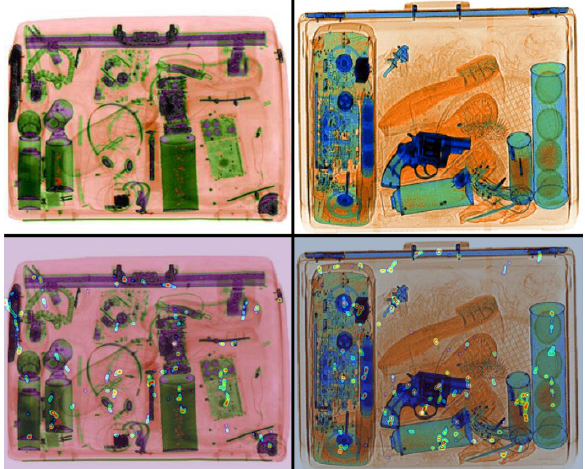
Figure 1 – Example X-ray images of simulated carry-on baggage used in this study. Images were used both without threats (baggage on left), and with specific threats inserted into the images (baggage on right). Gaze locations and durations are shown in a heat map format overlaid on the images in the bottom